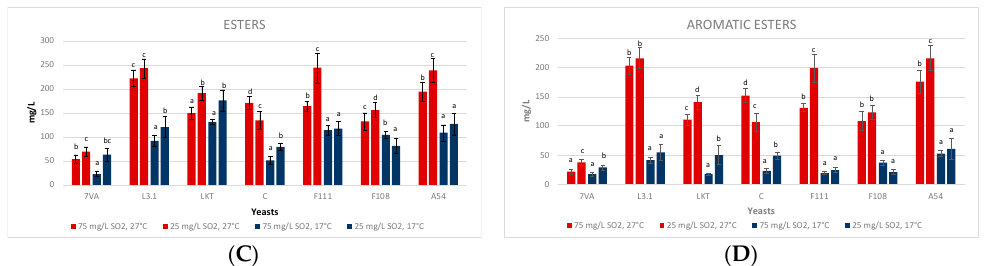
Figure 5. Concentration of ( A ) higher alcohols, ( B ) carbonyl compounds, ( C ) esters and ( D ) aromatic esters in the 10 mL fermentations by the seven strains at two temperatures (17, blue bars, and 27 °C, red bars) and two SO 2 contents (25 and 75 mg/L). Values are means ± sd ( n = 3). Different letter for the same yeast means significant differences ( p < 0.05).